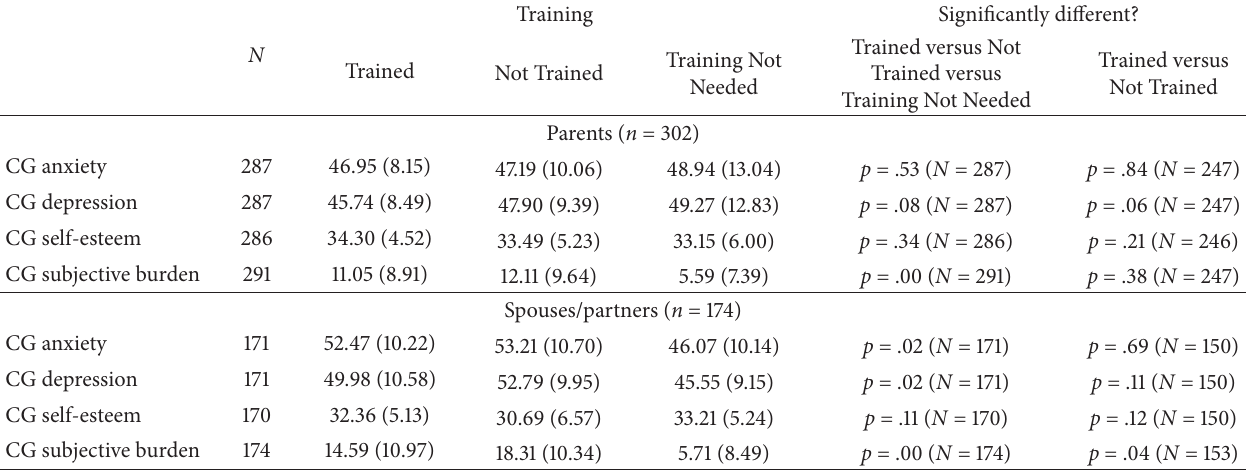
Table 3: Differences in caregiver mental health based on training received for navigating the VA or DoD based on caregivers’ relationship to care